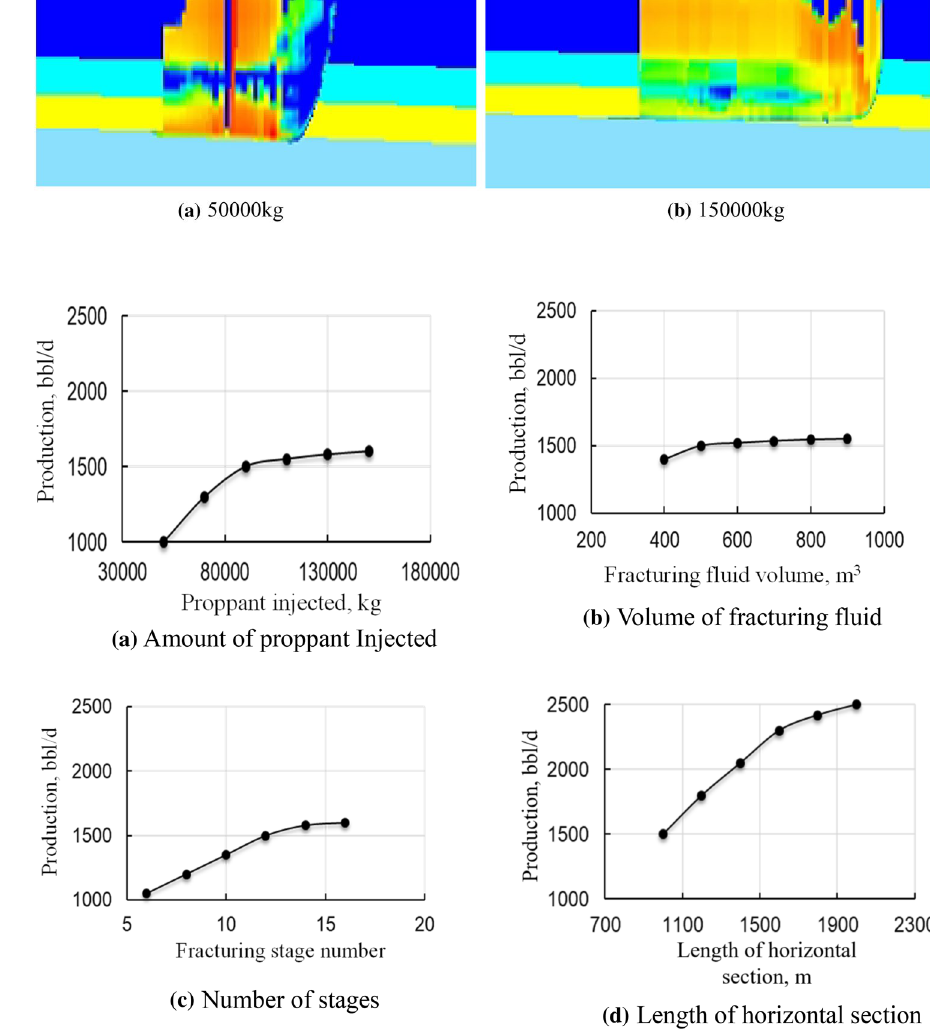
Fig. 21 Fracture under different proppant amount